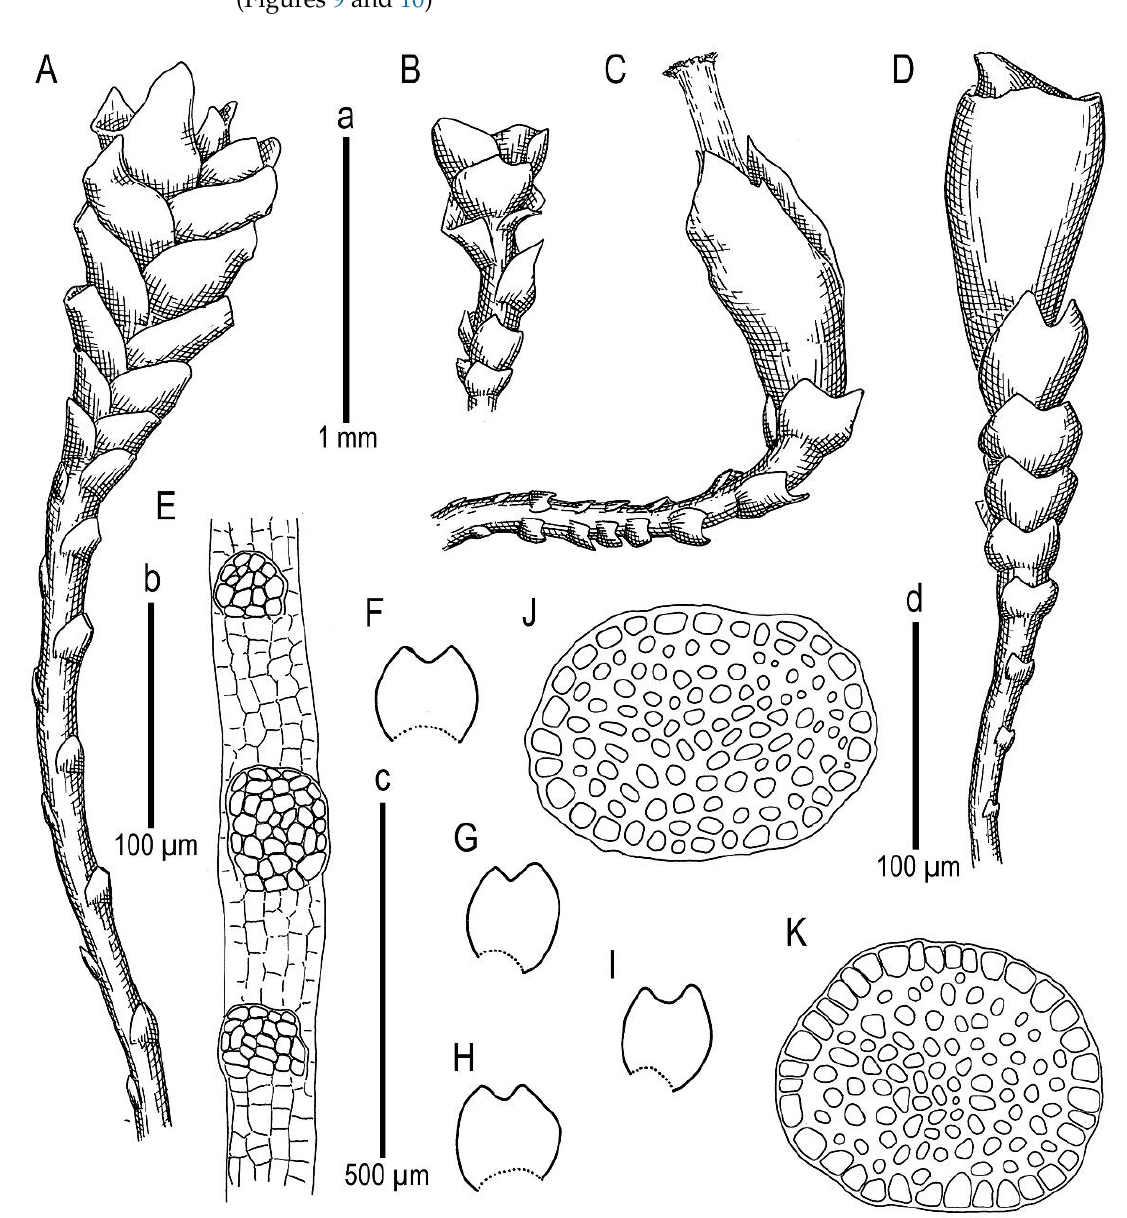
Figure 9. Marsupella stoloniformis N. Kitag.: ( A ) plant habit, fragment, dorsal view; ( B ) plant habit, fragment, dorsal view; ( C ) perianthous plant with seta; ( D ) perianthous plant, lateral view; ( E ) shoot with underleaves, fragment, ventral view; ( J , K ) stem cross-section; ( F – I ) leaves. Scale: a—1 mm for ( A – D ); b—100 µm for ( E ); c—0.5 mm for ( F – I ); d—100 µm for ( J , K ). ( A , D , F – J ) from V-11-11-17 (VBGI); ( B , C , E , K ) from Mizutani 2788 (KYO).